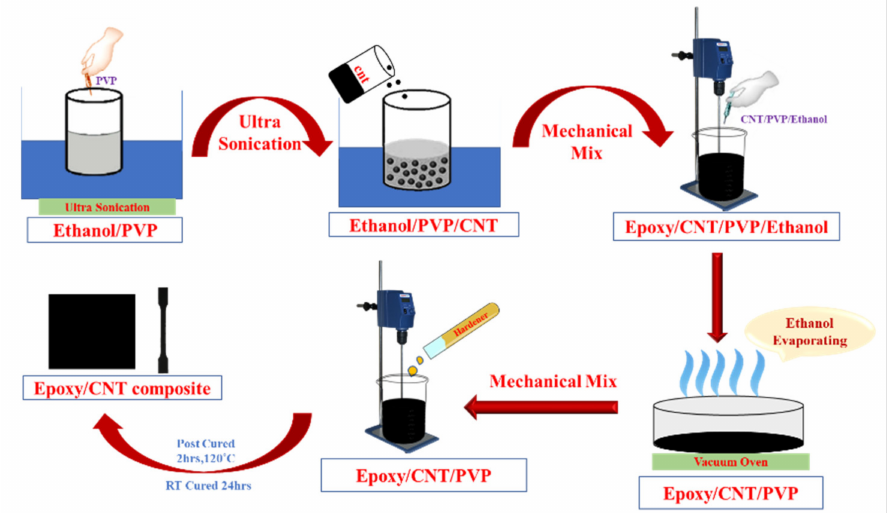
Figure 2. Preparation schematic of the Epoxy/CNT nanocomposites.